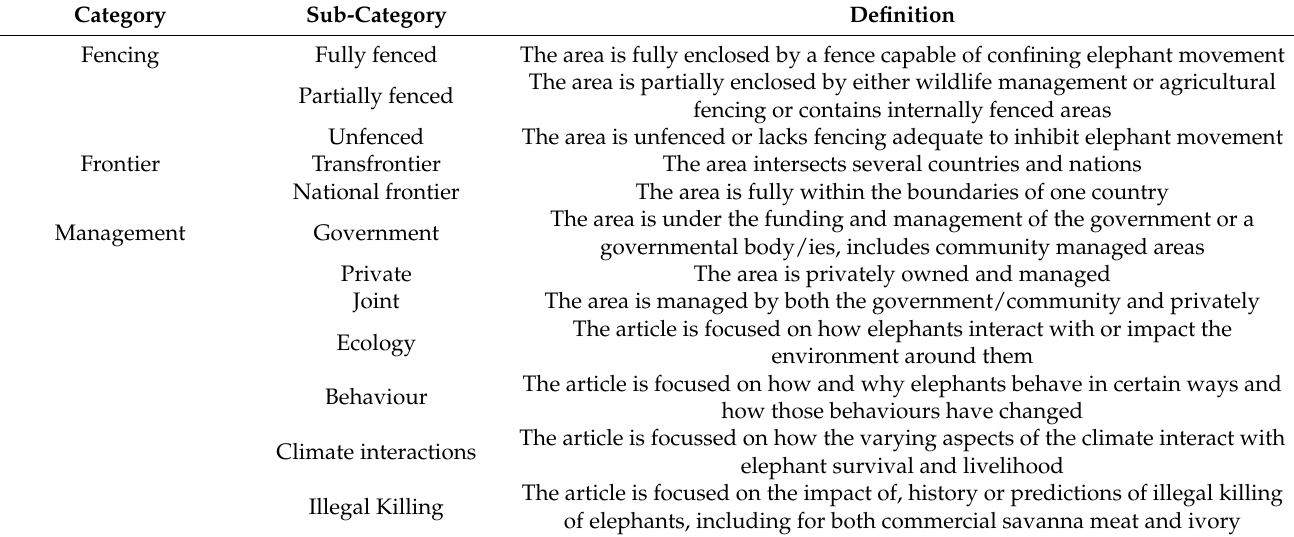
Table 1. Definitions of each category used to refine this systematic